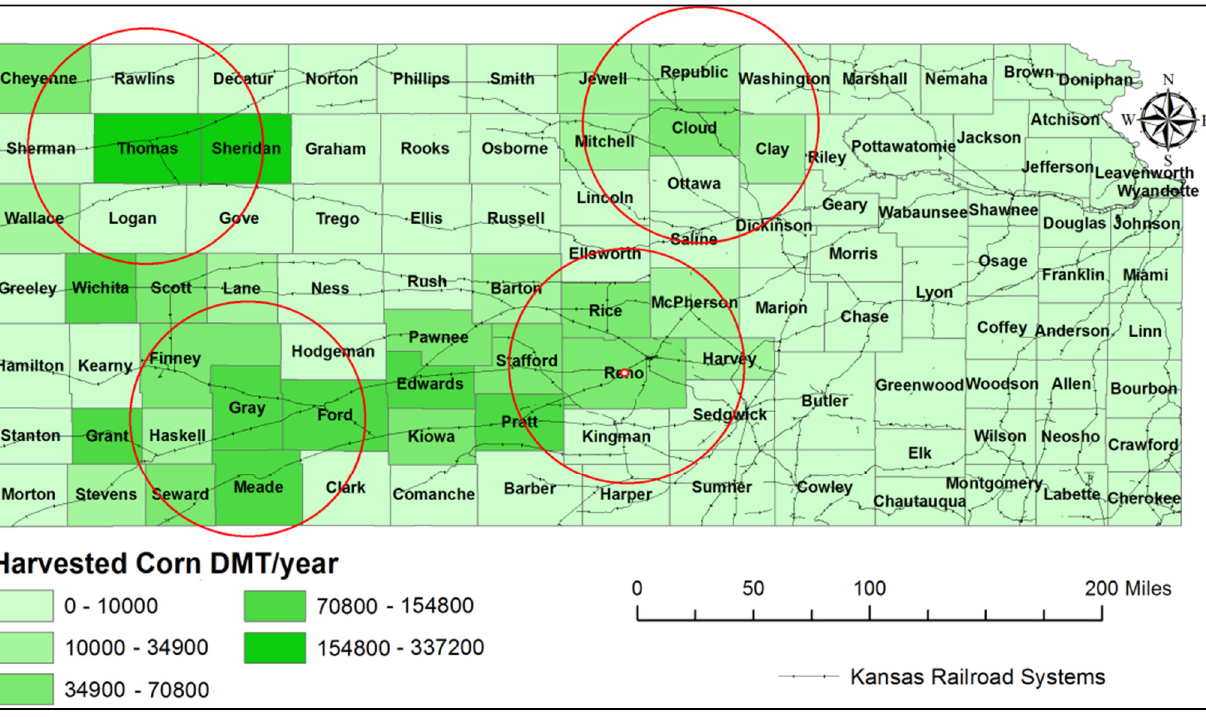
Figure 2. Scenario 1 depot configuration based on equal spatial siting between depots and infrastructure availability. The red circle shows the biomass supply radius. The depots are located at the center of the circle and receive feedstock from counties within an 80-km (50-miles) radius. The red point at the centroid of Reno County corresponds to the location of the